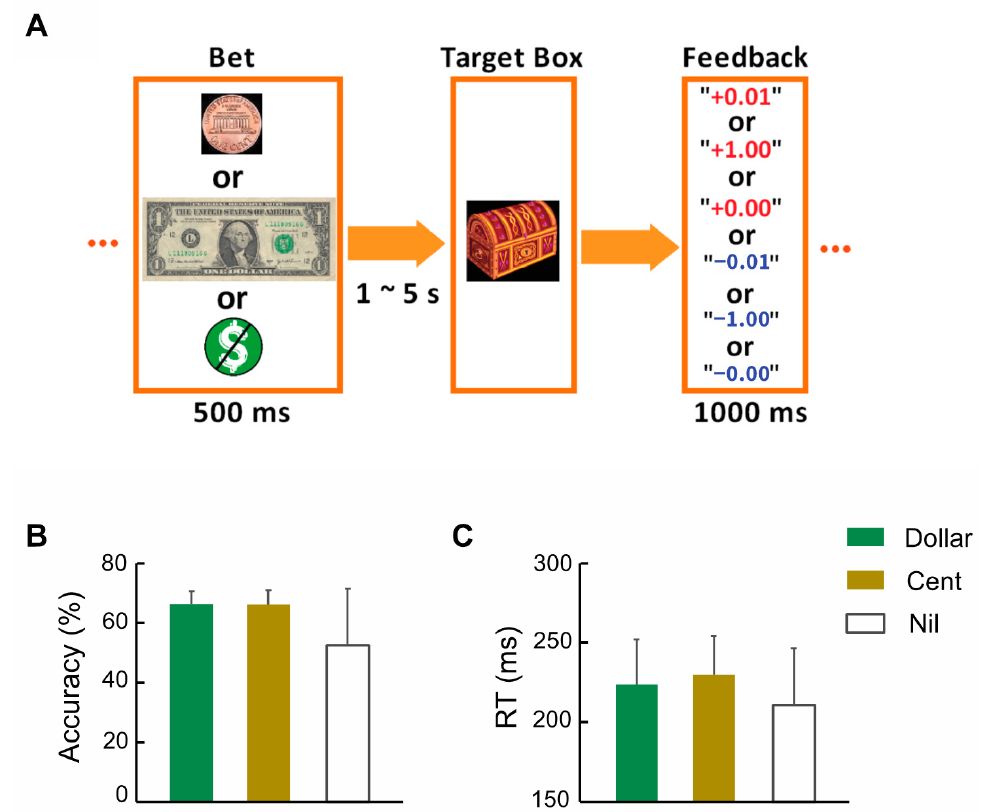
Figure 1. ( A ) Monetary incentive delay task: Each trial starts with a bet (a dollar, a cent, or no money). After a randomized interval of 1–5 s, a target box is presented and disappears after a response window. Subjects are requested to make a response as quickly as possible to collect the money (win) before it disappears, following by feedback that indicates the amount of money won (in red) or lost (in blue). ( B ) Accuracy rate and ( C ) RT of trials (mean ± SD).